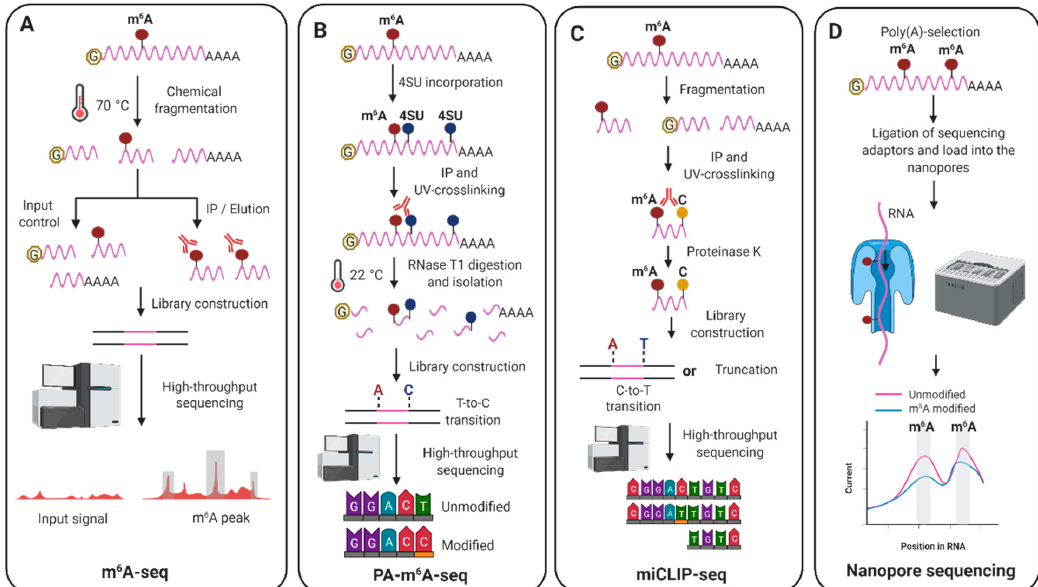
Figure 2. The most common transcriptome-wide m 6 A profiling techniques used to locate m 6 A in viral RNAs. ( A ) The first step of the m 6 A-seq technique consists of the chemical fragmentation of the RNA into 100–200 nucleotides-long RNA molecules. An input control (which does not undergo m 6 A-immunoprecipitation) and an m 6 A-immunoprecipitated (IP) sample are required to build cDNA libraries for deep-sequencing and subsequent bioinformatic analysis. m 6 A-seq offers a low-resolution approach to map m 6 A modifications because of the relatively large size of the starting fragmented RNAs. ( B ) Photo-crosslinking-assisted m 6 A-sequencing (PA-m 6 A-seq) requires incubating cells with 4-thiouridine (4SU), which is incorporated into mRNAs. Full length mRNAs are then immunoprecipitated with m 6 A antibodies and UV-crosslinked. Next, crosslinked mRNAs are digested into around 30 nucleotides-long molecules that are isolated to prepare the cDNA libraries. Crosslinked 4SU is read as C during reverse transcription, therefore T to C transitions can be identified when compared to the reference genome. ( C ) In miCLiP-seq, RNA containing m 6 A-modifications is fragmented, immunoprecipitated (IP) using an anti-m 6 A antibody and UV-crosslinked to the IP antibody. As similarly to the previous techniques, during library preparation adapters are ligated to the precipitated RNA but in this case the 5 ′ -end of the RNA is radioactively labeled. After purification of the RNA-antibody complexes using SDS-PAGE and membrane transfer, the RNA fragments are then reverse-transcribed leading to either a transition of C to T or truncations in cDNA. Following library construction and high-throughput sequencing localization of m 6 A modifications at single nucleotide resolution is achieved. ( D ) Nanopore sequencing of m 6 A modifications takes advantage of changes in electric current when a nucleotide containing a modification traverses a nanopore. Using specialised software, m 6 A modifications can then be identified. This allows for fast, accurate and sensitive detection of long sequencing reads reaching up to 2